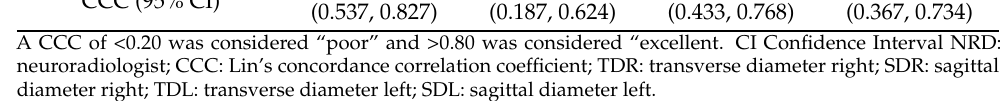
Table 2. Intra-rater agreement in ONSD Magnetic Resonance Imaging (MRI) assessment for NRD 1. NRD 1— Assessment t1 vs. t2